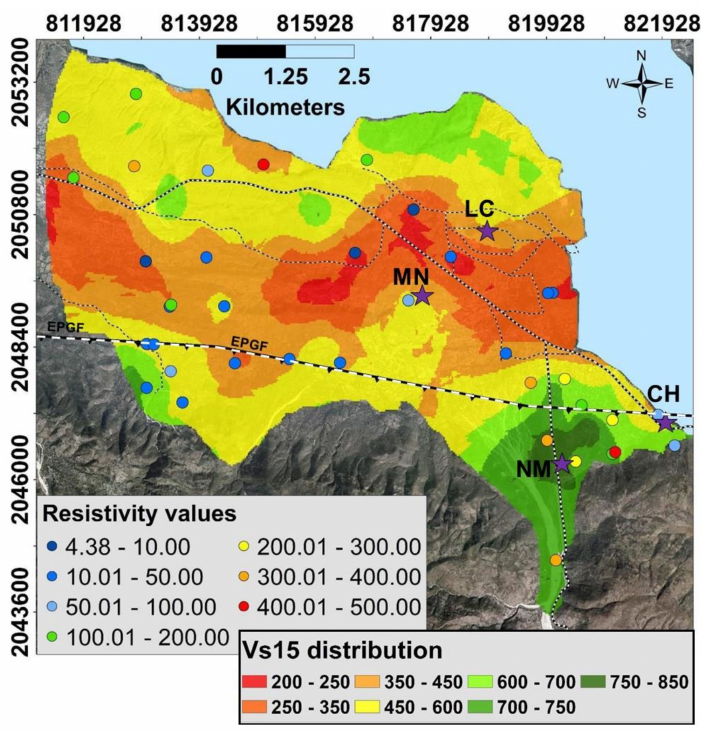
Figure 16. Map of shear wave velocity distribution in terms of Vs15 compared with local resistivity values averaged over the upper 15 m of the corresponding ERT profile.